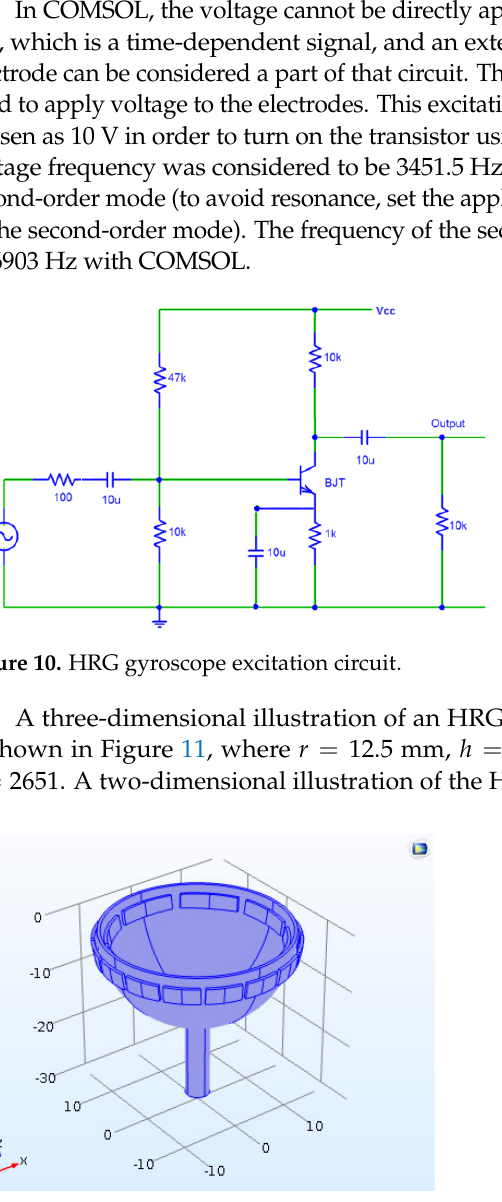
Figure 11. HRG simulated in COMSOL software.